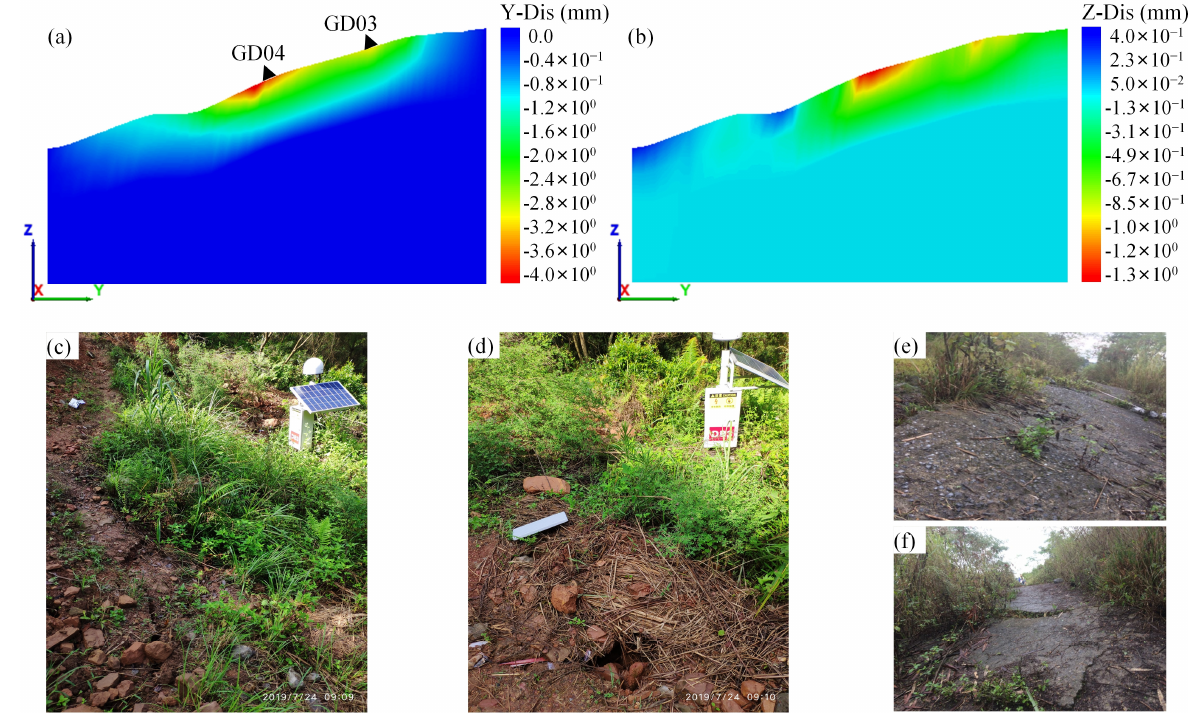
Figure 12. Simulation results and on-site findings: ( a , b ) displacement contours in the horizontal and vertical directions, respectively; ( c , d ) cracks around GD03; ( e , f ) bulges in the lower slope.